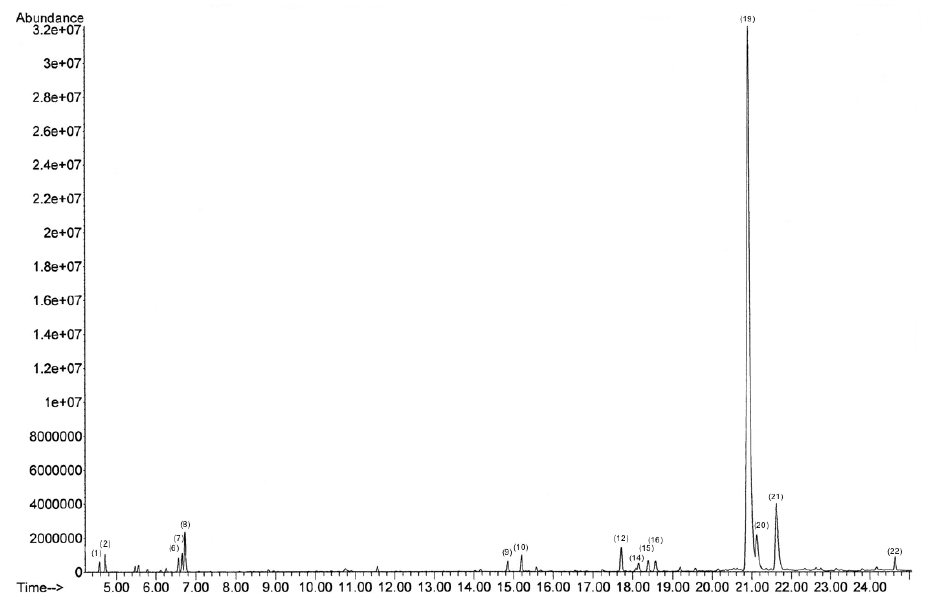
Figure 1. Chromatogram of fifteen identified compounds in essential oil from hydrodistillation of Prostanthera centralis leaves. Numbered peaks correspond to identified compounds in Table